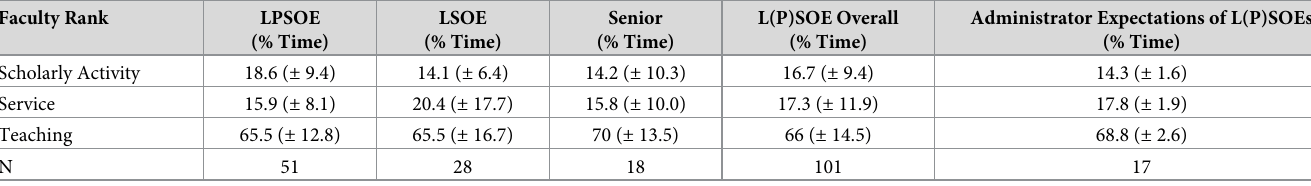
Expectations for the amount of time that L(P)SOE faculty and administrators perceived L(P)SOEs should be spending in each of the three domains, scholarly activity, service, and teaching. These values are reported as average percentages (combined out of 100%). The standard deviation for each value is presented in